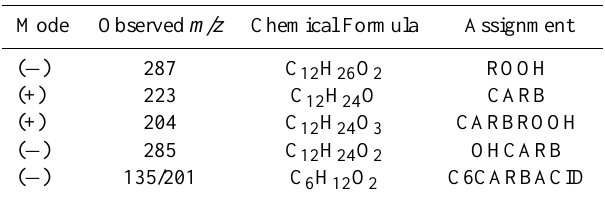
Table 3. Selected ions monitored by the CIMS for n -dodecane and 2-methylundecane.